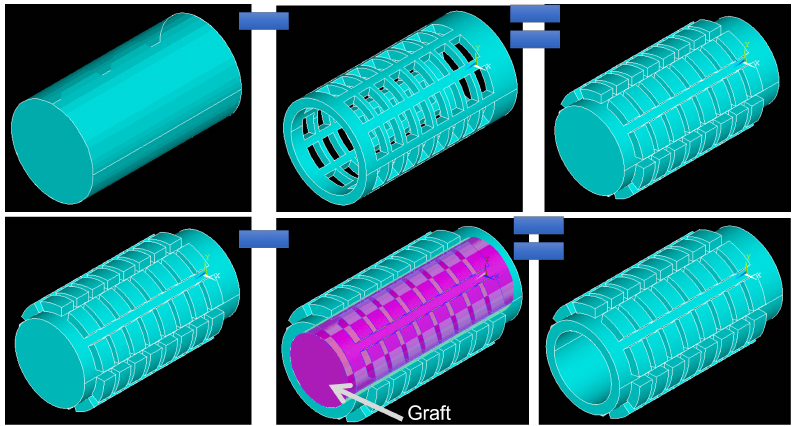
Figure 11. Preparation of the model of the fluid volume in the implant.